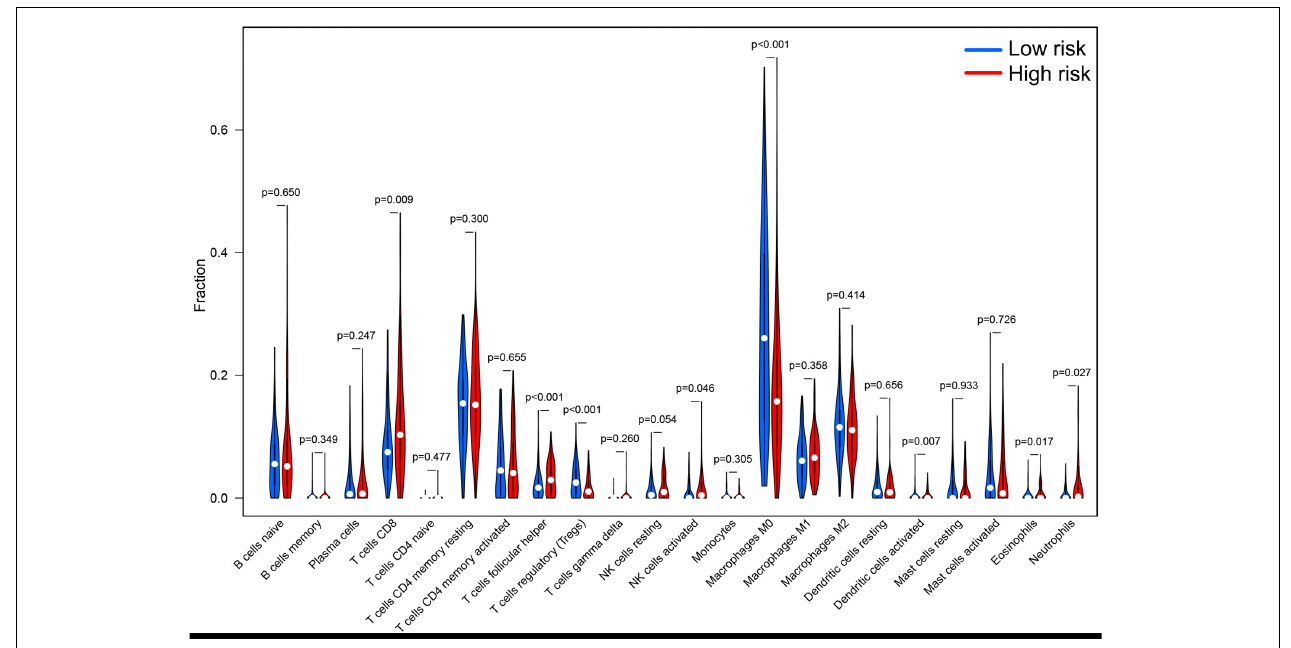
FIGURE 6 | The differential infiltrating levels of 22 immune cell types in high-risk group and low-risk group. Patients with high prognostic risk showed larger infiltration of T cells CD 8 + , T cells follicular helper, NK cells activated, dendritic cells activated, eosinophils and neutrophils, while low risk score correlated with more infiltration of T cells regulatory (Treg) and macrophages M0. P value < 0.05 was regarded as a statistical